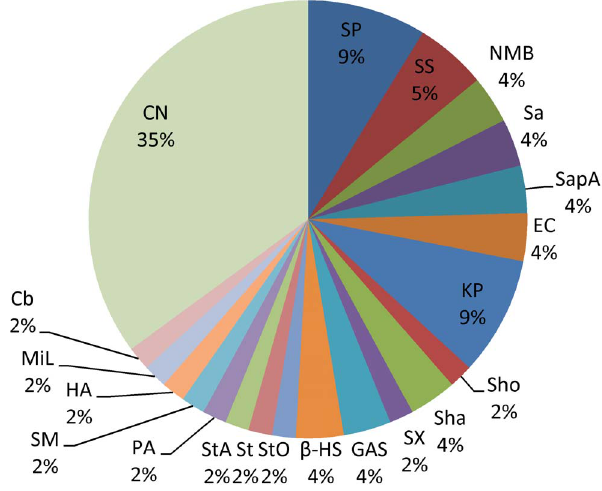
Figure 5. Etiological distribution of encephalitis-meningitis syndrome in Guangxi, China, 2009–2011. Of 57 etiologies cultured from specimens of encephalitis-meningitis syndromes: Streptococcus pneumonia (SP,5), Streptococcus suis (SS,3), Neisseria meningitidis sero- group B (NMB,2), Salmonella (Sa,2), Salmonella paratyphi A (SapA,2), Escherichia coli (EC,2), Klebsiella pneumonia (KP,5), Staphylococcus hominis (Sho,1), Staphylococcus haemolyticus (Sha, 2), Staphylococcus xylosus (SX ,1), Group A streptococcus (GAS,2), b -hemolytic streptococcus ( b -HS, 2), Streptococcus oralis (StO, 1), Streptococcus (St,1), Streptococcus agalactiae (StA,1), Pseudomonas aeruginosa (PA,1), Stenotrophomonas maltophilia (SM,1), Hafinia alvei (HA,1), Micrococcus luteus (MiL,1), Coryne- bacterium (Cy,1), Cryptococcus neoformans (CN,20).